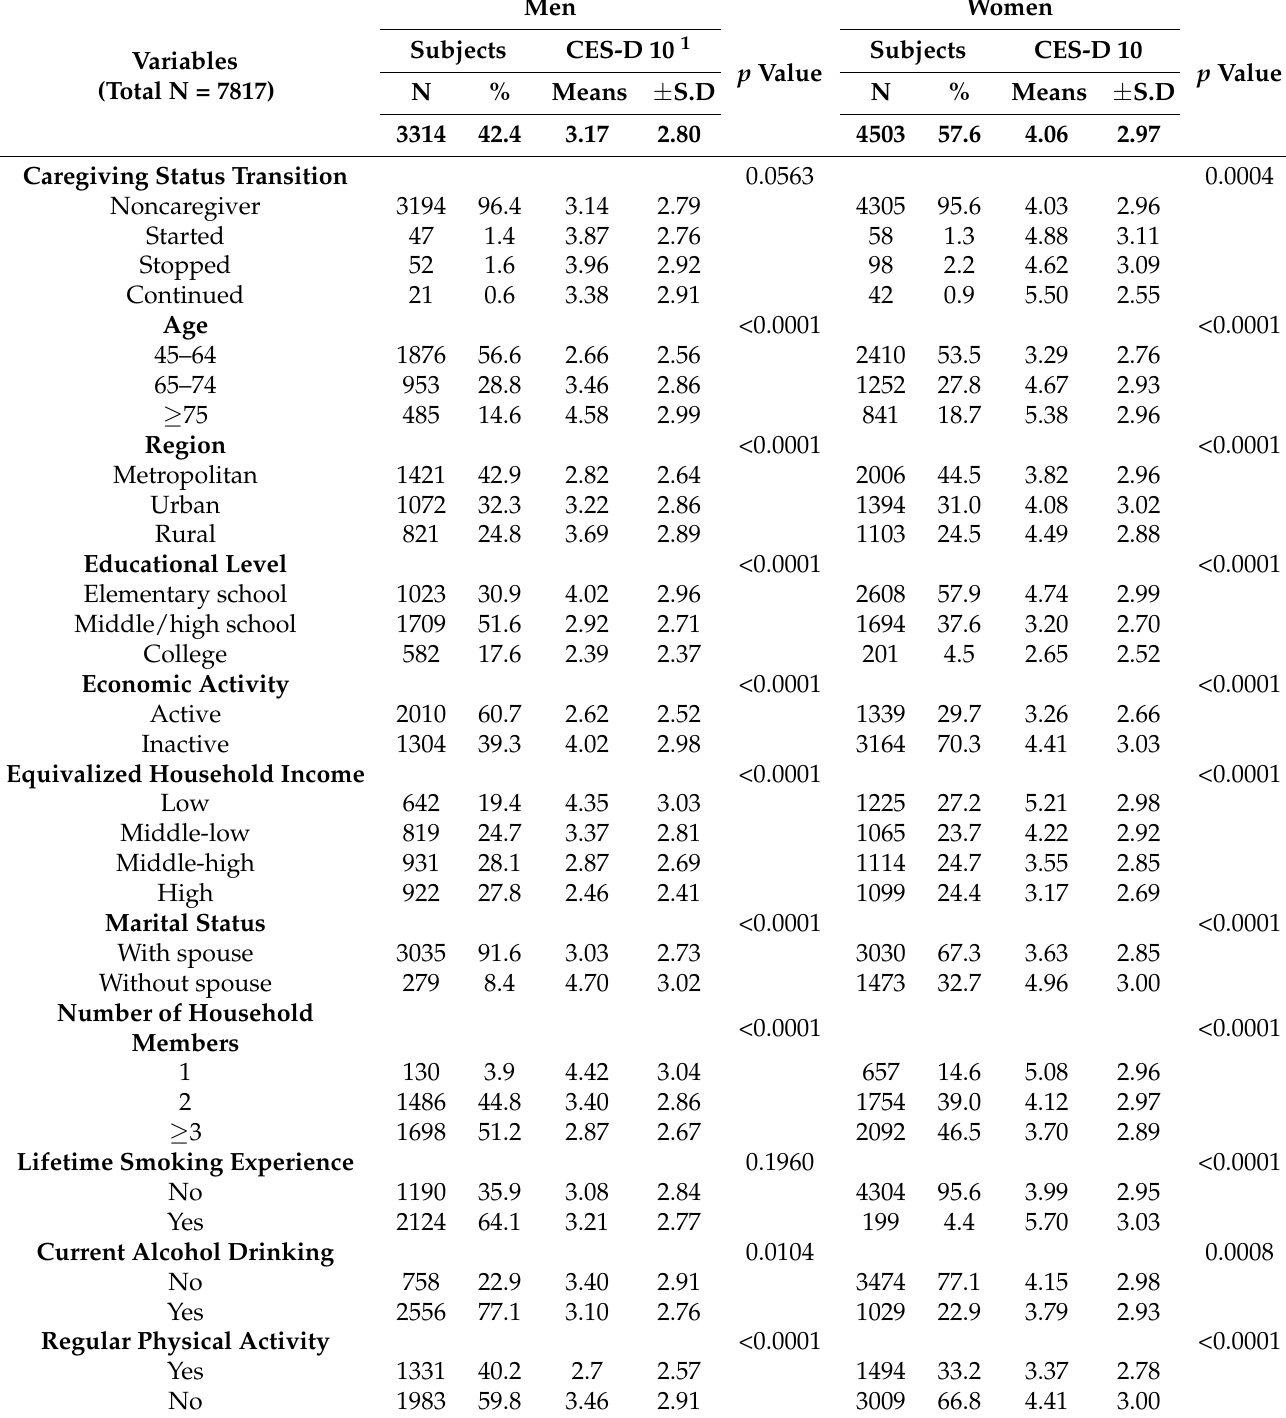
Table 1. General characteristics of study subjects (2006–2008 baseline